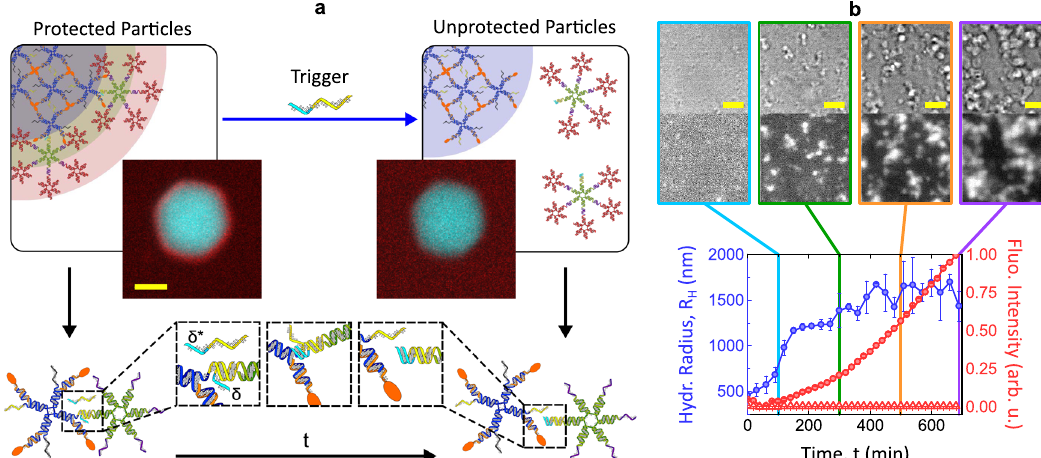
Fig. 3 Triggered release of protective corona leads to particle aggregation. a Schematic representation of the toehold-mediated strand displacement mechanism leading to isothermal release of the protective corona. A trigger strand of sequence δ * α * binds the toehold domain δ on the inner corona motifs, displacing the α − α * bond between the latter and the core motif, and disrupting the protective shell. The confocal micrographs show a polyhedral core – shell particle before (left) and 1 min after trigger addition (right). Core motifs are labeled with fl uorescein (cyan) and outer corona motifs with Alexa Fluor 647 (red). Note the increase in the background fl uorescence from free corona motifs after the corona displacement. Scale bar 2 μ m. b Corona displacement leads to the exposure of the “ sticky ” C-star core and subsequent particle aggregation, assessed by measuring the time-dependent hydrodynamic radius as determined via DDM (blue circles) and the normalized fl uorescence intensity of labeled core motifs (red circles) after the addition of trigger strands ( t = 0). The increase in R H observed upon trigger addition follows from the formation of larger aggregates, while the increase in the fl uorescence trace is caused by their progressive sedimentation at the bottom of the cell, where the signal is recorded. For both observables, data are shown as mean ± standard deviation of 3 independent repeats. Red triangles indicate a control fl uorescent trace measured in the absence of trigger. The constant and low value con fi rms the absence of spontaneous sedimentation. Top: bright fi eld and fl uorescence micrographs at different time-points after the addition of the trigger ( t = 100, 300, 500, and 690 min). All scale bars 25 μ